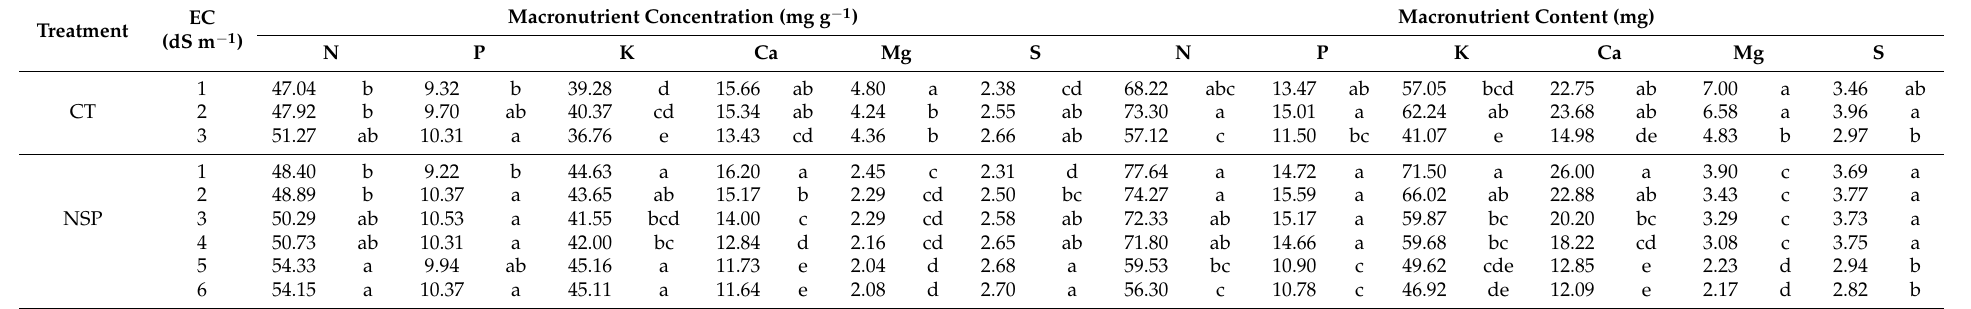
Table 2. Macronutrient content of red perilla plants grown under various EC levels of greenhouse nutrient solution (CT) and the newly-developed nutrient solution for red perilla (NSP) after 7 weeks of transplanting. Different letters within the columns indicate significant differences by Duncan’s multiple range test at p ≤ 0.05 ( n = 6). Treatment